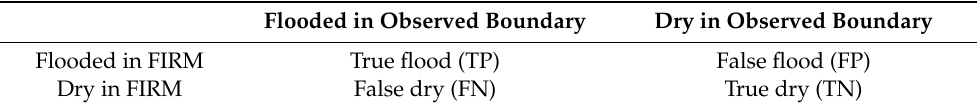
Table 2. A confusion matrix for flood